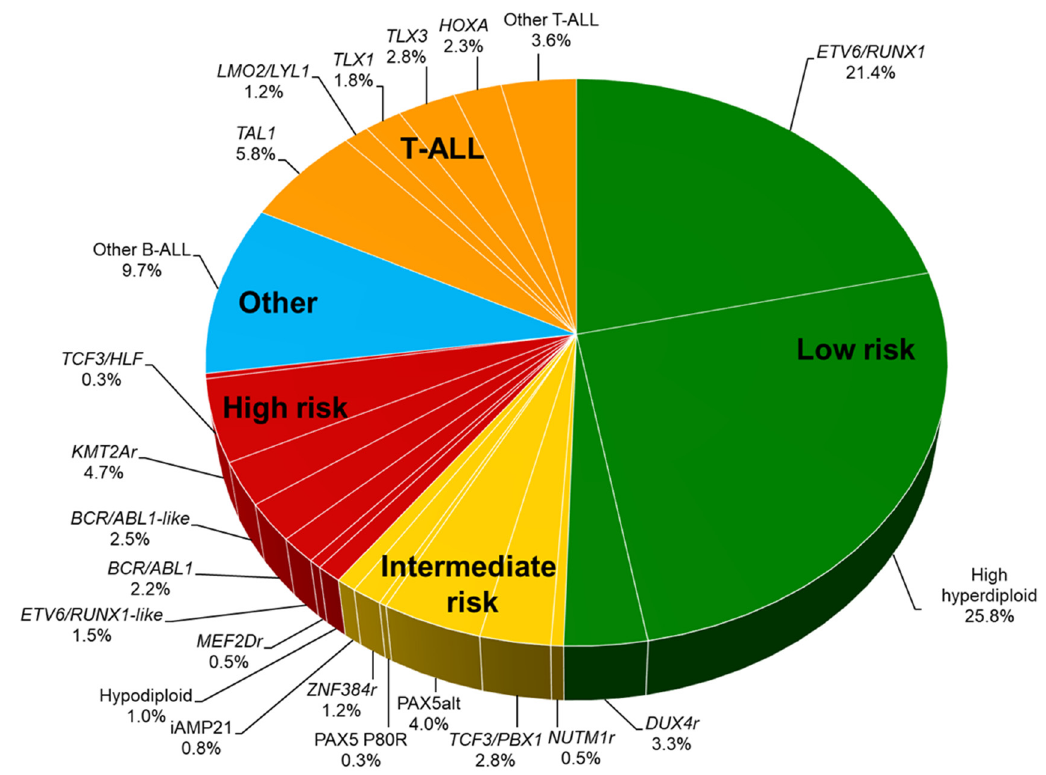
Figure 2. Distribution of genetic subtypes Genetic subgroups are listed based on the patients treated in St. Jude Total Therapy Study XVI and on patients with T-ALL who were treated in Children’s Oncology Group studies and evaluated for genetics as part of the Therapeutically Applicable Research to Generate Effective Treatments initiative [11,12]. Percentages are the approximate incidence in pediatric ALL. B-ALL is categorized as low-, intermediate-, or high-risk disease. For T-ALL, no genetic subtypes are clearly associated with outcomes, but the group as a whole is considered an intermediate-risk group. Abbreviations: ALL, acute lymphoblastic leukemia. Table 2. Genetic subtypes and treatment approach.